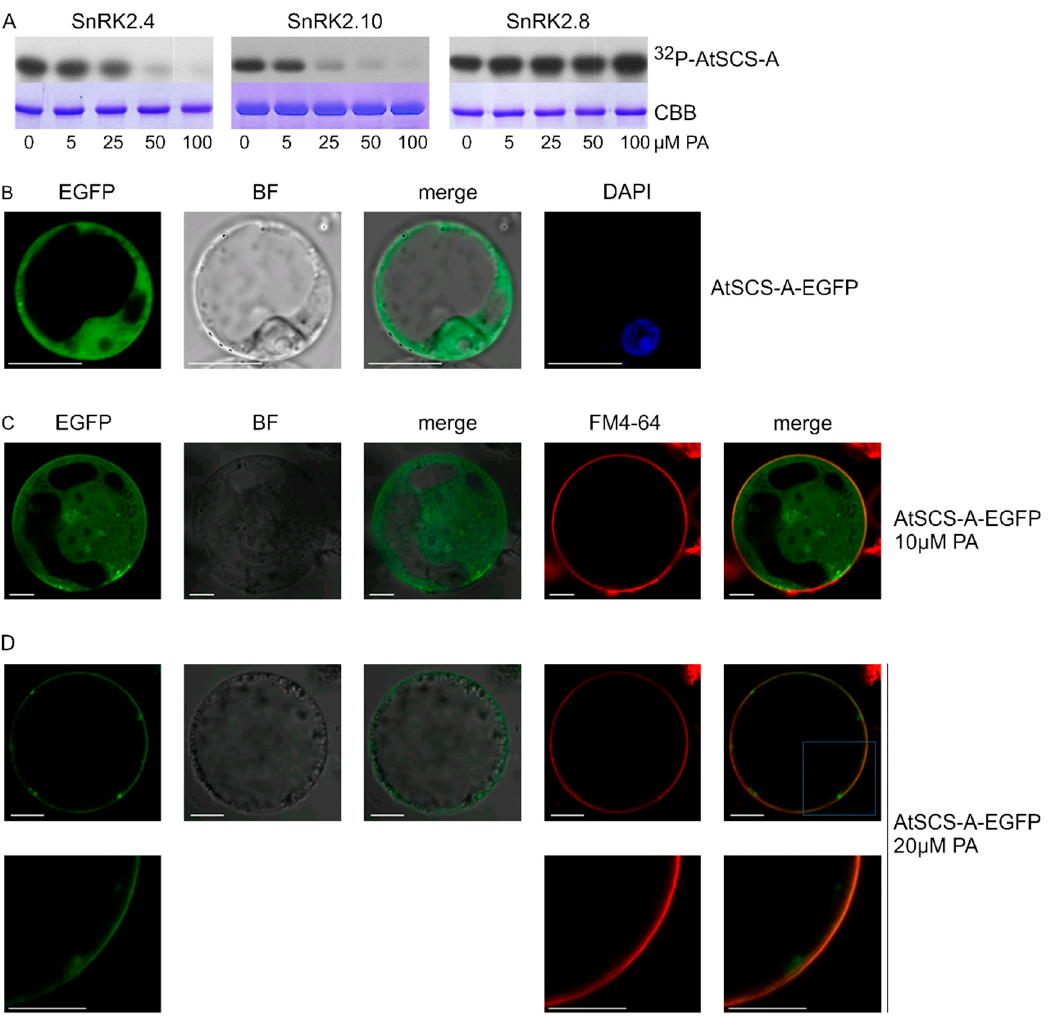
Figure 5. E ff ect of PA on phosphorylation of SnRK2-interacting calcium sensor-A (AtSCS-A) by ABA-non-activated SnRK2s and its subcellular localization. ( A ) Phosphorylation of AtSCS-A by recombinant GST-fused kinases SnRK2.4, SnRK2.10, and SnRK2.8 was analyzed in vitro in the